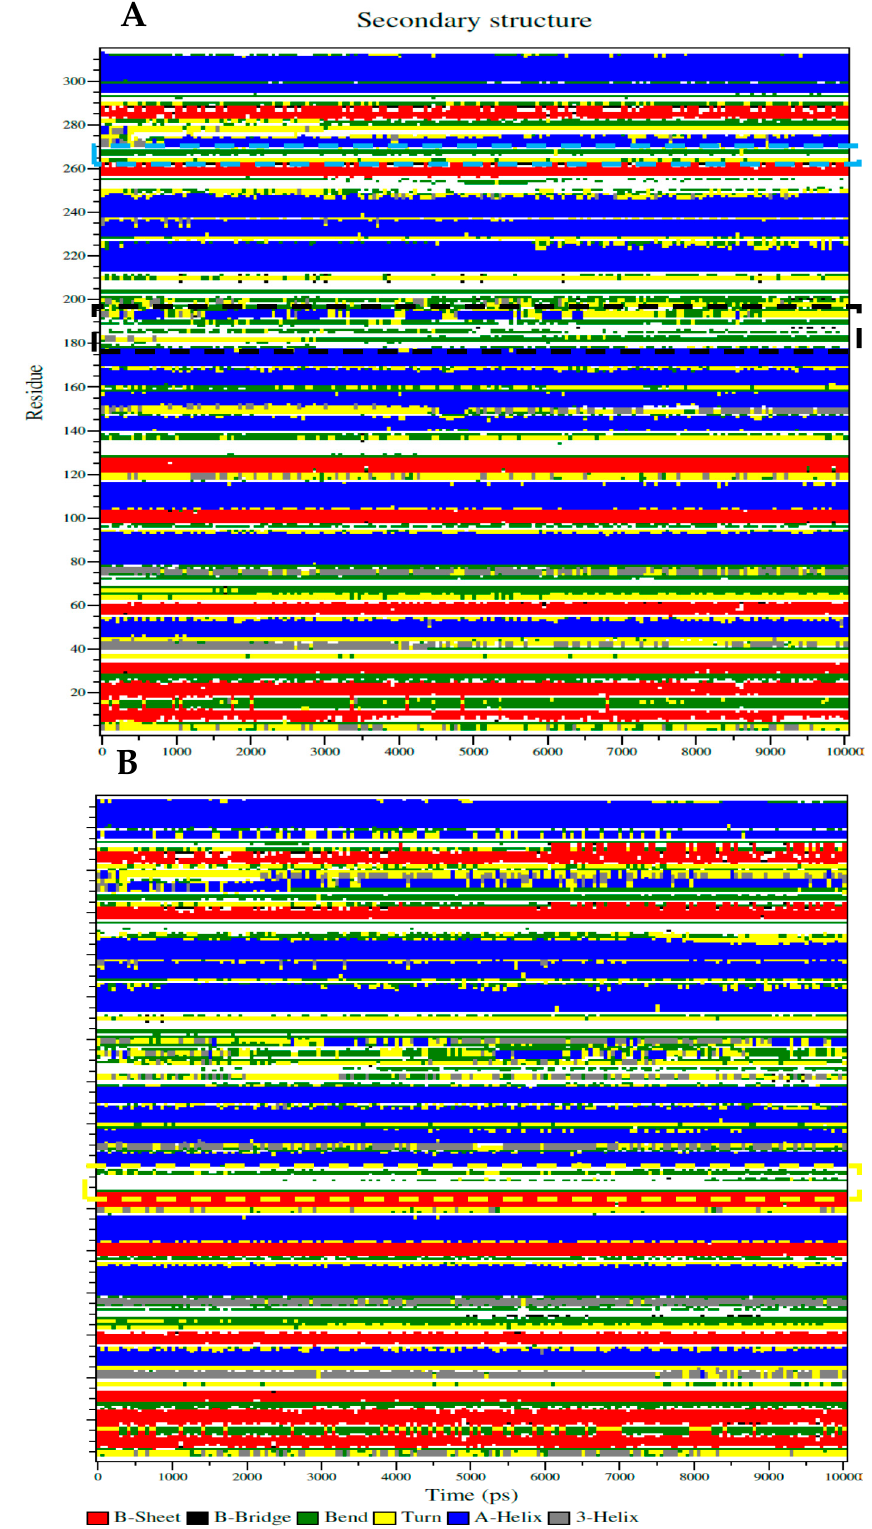
Figure 5 . The Dictionary of Secondary Structure protein (DSSP) represented with secondary structure changes of sEH with inhibitor 1 ( A ) or 4 ( B ) (yellow square: Thr360-Pro371, black square: Ser415-Glu424, and blue square: Glu494-Pro501).